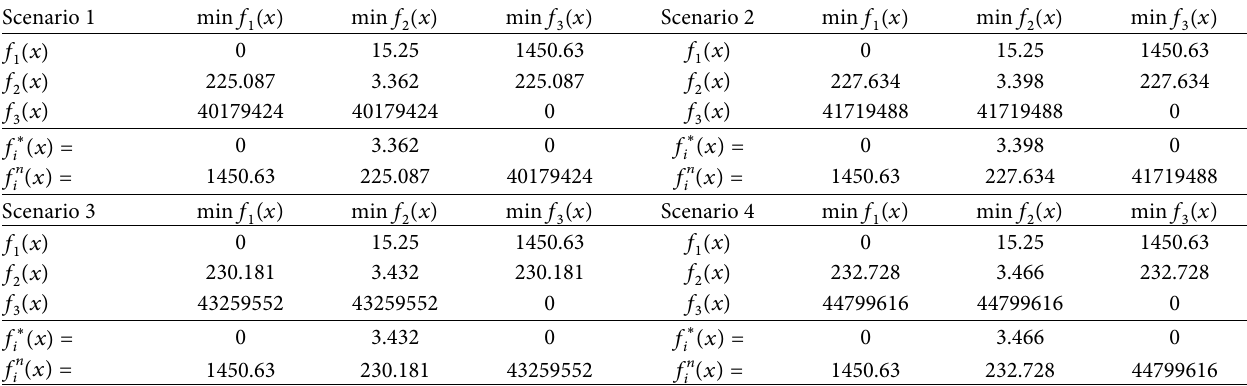
Figure 8: Seismic intensity map of Kadiköy for model C [1]. Figure 6: Seismic intensity map of Kadiköy for model A [1]. Table 5: Utopia and nadir points for each event